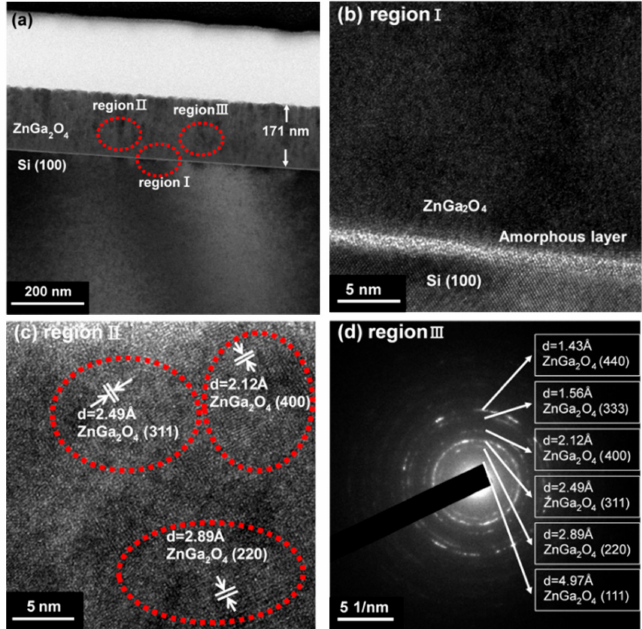
Figure 5. ( a ) Cross-sectional TEM image of the ZnGa 2 O 4 / Si(100) sample. HRTEM images focused on ( b ) region I, ( c ) region II, and ( d ) region